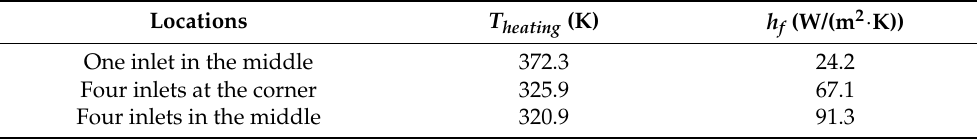
Table 6. Simulation results under different fluid inlet